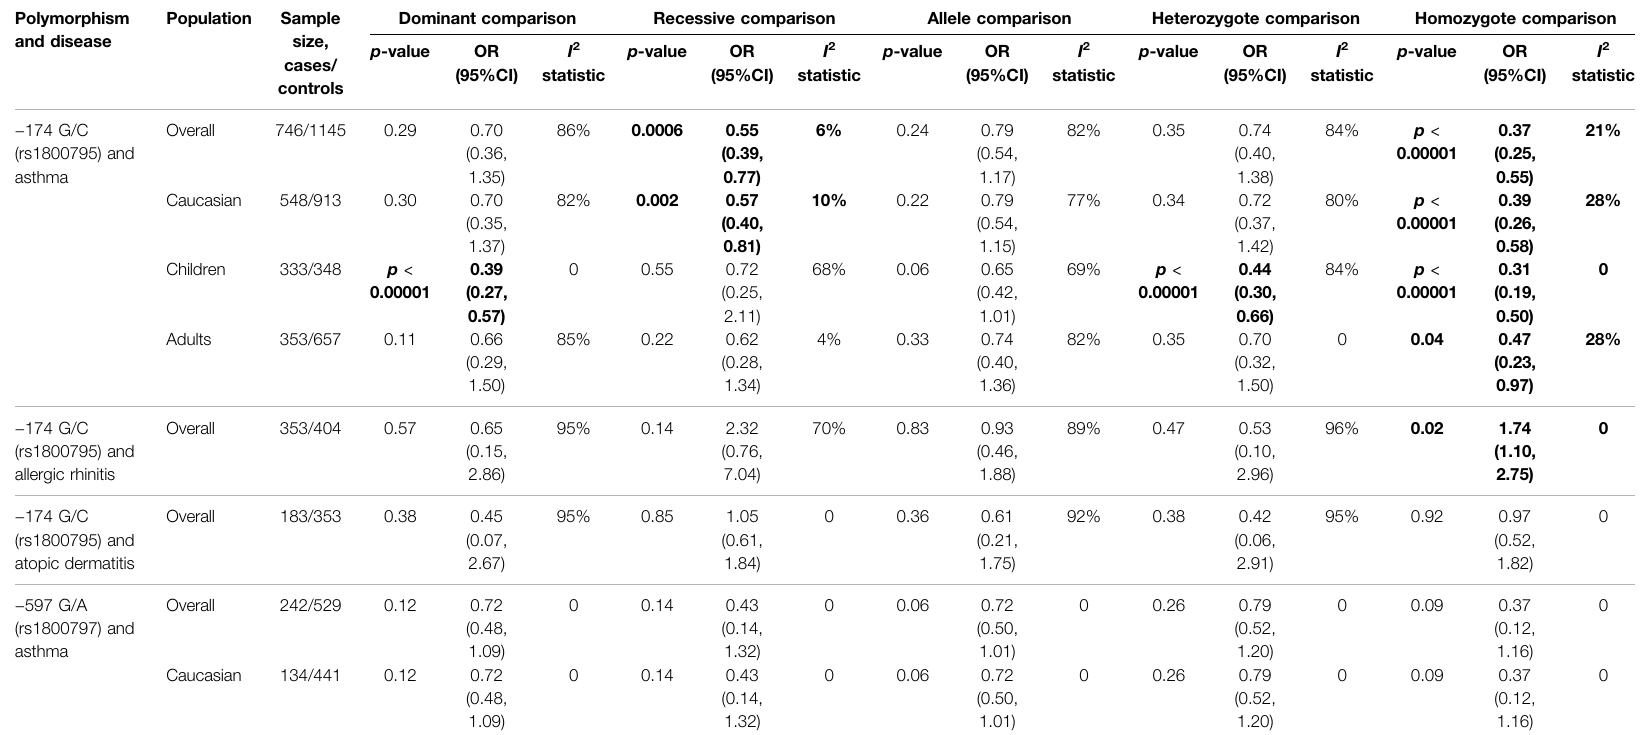
Abbreviations: OR, odds ratio; CI, con fi dence interval. The values in bold denote that there are statistically signi fi cant differences between cases and